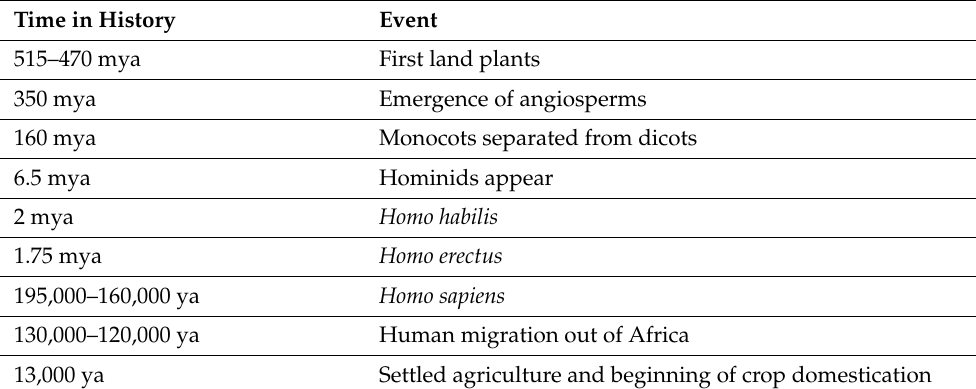
Table 1. Evolutionary timescale of life on land illustrating that crop domestication is a very recent event compared with evolution of land plants. mya—million years ago, ya—years ago. Data from multiple sources referred in